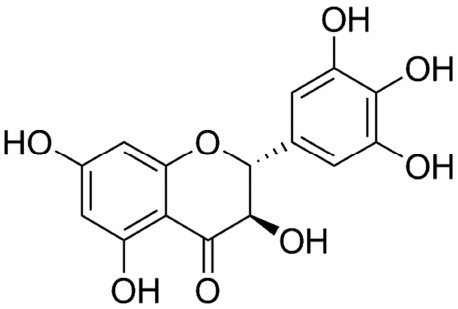
Figure 1 . Chemical structure of dihydromyricetin (DMY). Figure 1. Chemical structure of dihydromyricetin